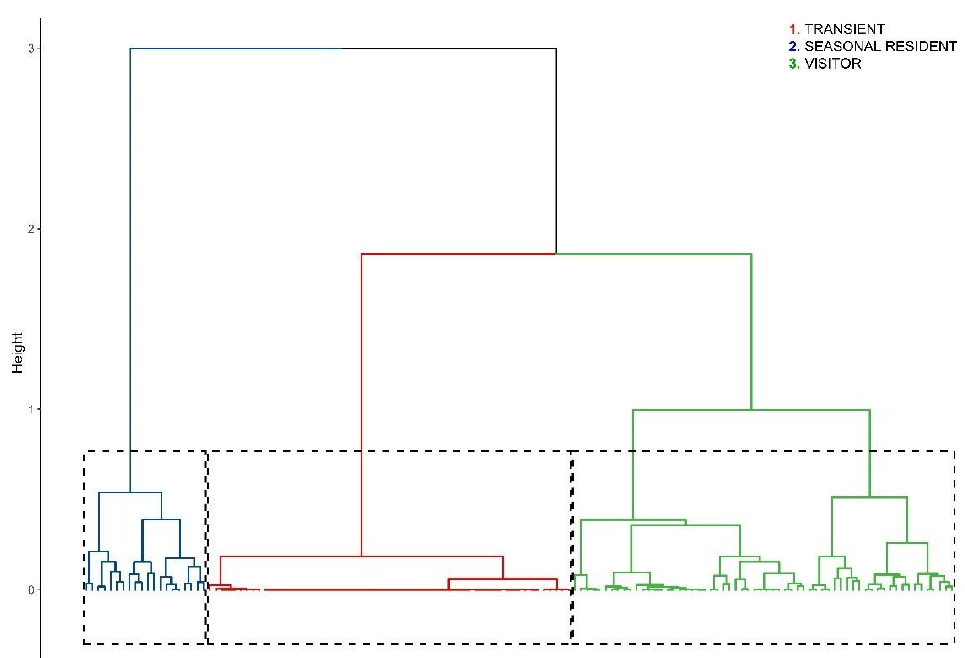
Figure 4. The dendrogram of the agglomerative hierarchical cluster analysis performed to identify the different degree of site fidelity of photo-identified individuals in the Gulf of Taranto. Cluster 1 (transient) is shown in red, cluster 2 (seasonal resident) in blue and cluster 3 (visitor) in green. Table 2. Mean, standard deviation (Sd), minimum (Min) and maximum (Max) values of the monthly, seasonal, annual sighting rate and the relative span time index estimated for the individuals of bottlenose dolphin included in the agglomerative hierarchical cluster analysis.